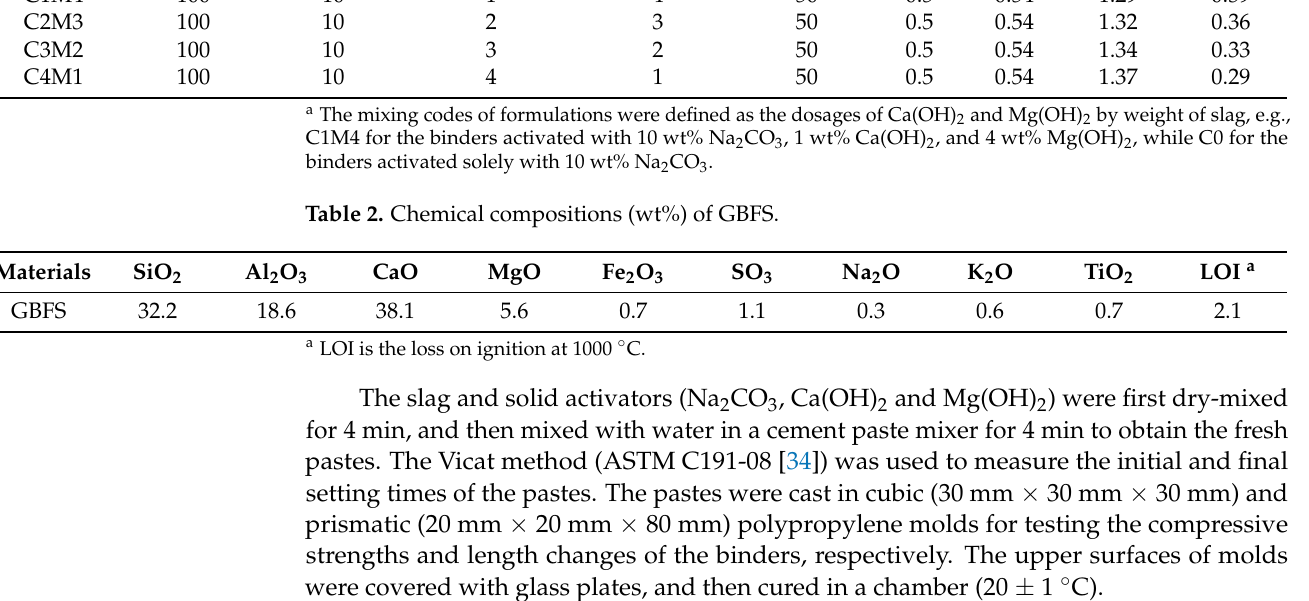
Table 1. Mix proportions of one-part Na 2 CO 3 -activated binders.